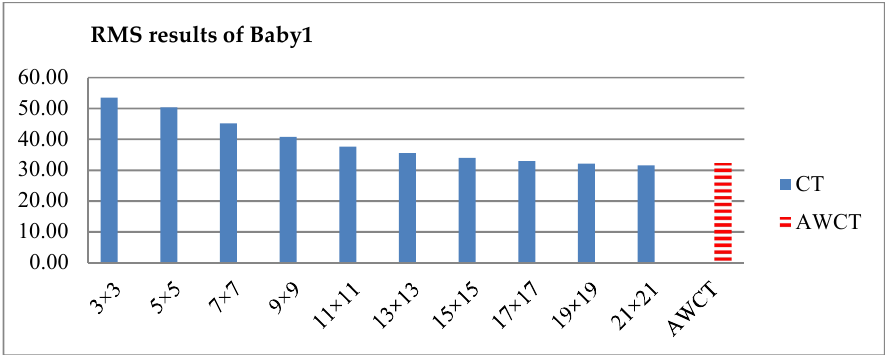
Figure 20. RMS comparison results of Baby1 between AWCT and CT. Table 2. Comparison of AWCT and CT.